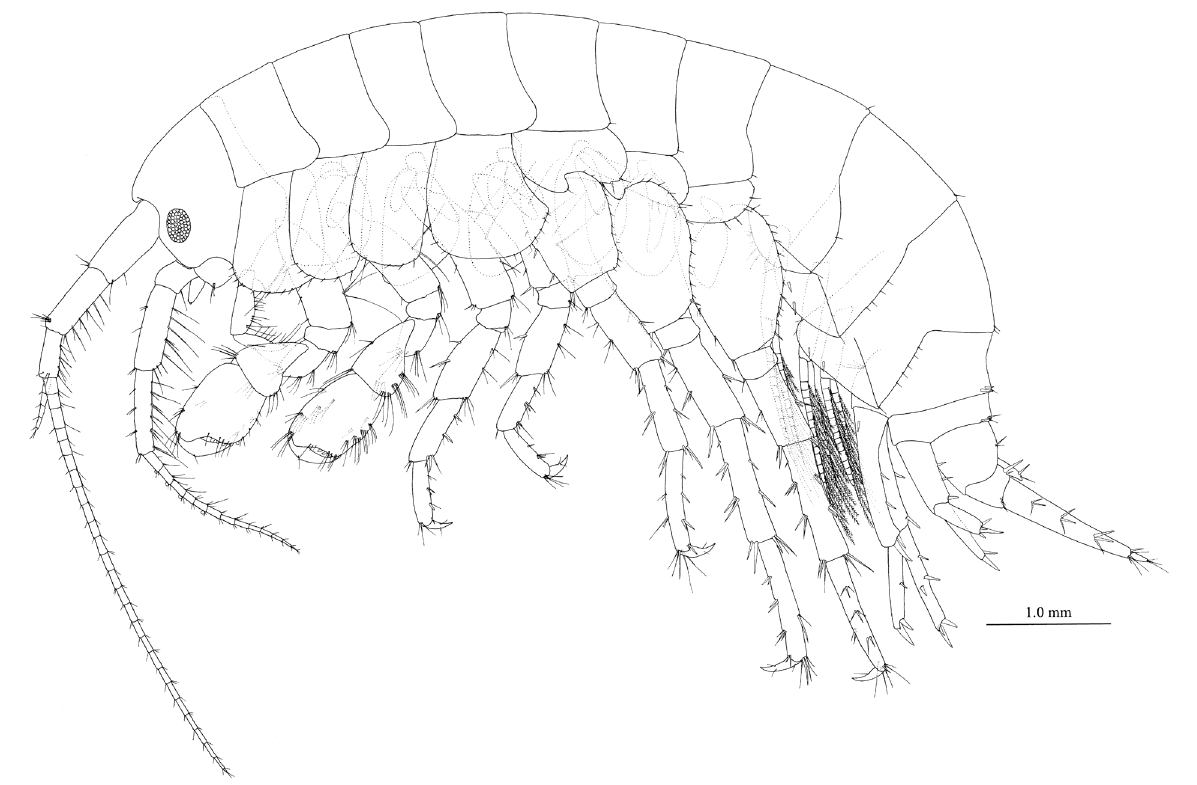
Figure 2. Jesogammarus bousfieldi sp. n., holotype, male (9.8 mm), NSMT-Cr 25470. Habitus, lateral view. apical and inner margins, respectively; outer plate with plumose setae on apical margin and robust setae on inner margin; palp 4-articulate, article 2 with inner marginal and submarginal rows of setae, article 3 with facial setae, article 4 slightly curved inward, with slender